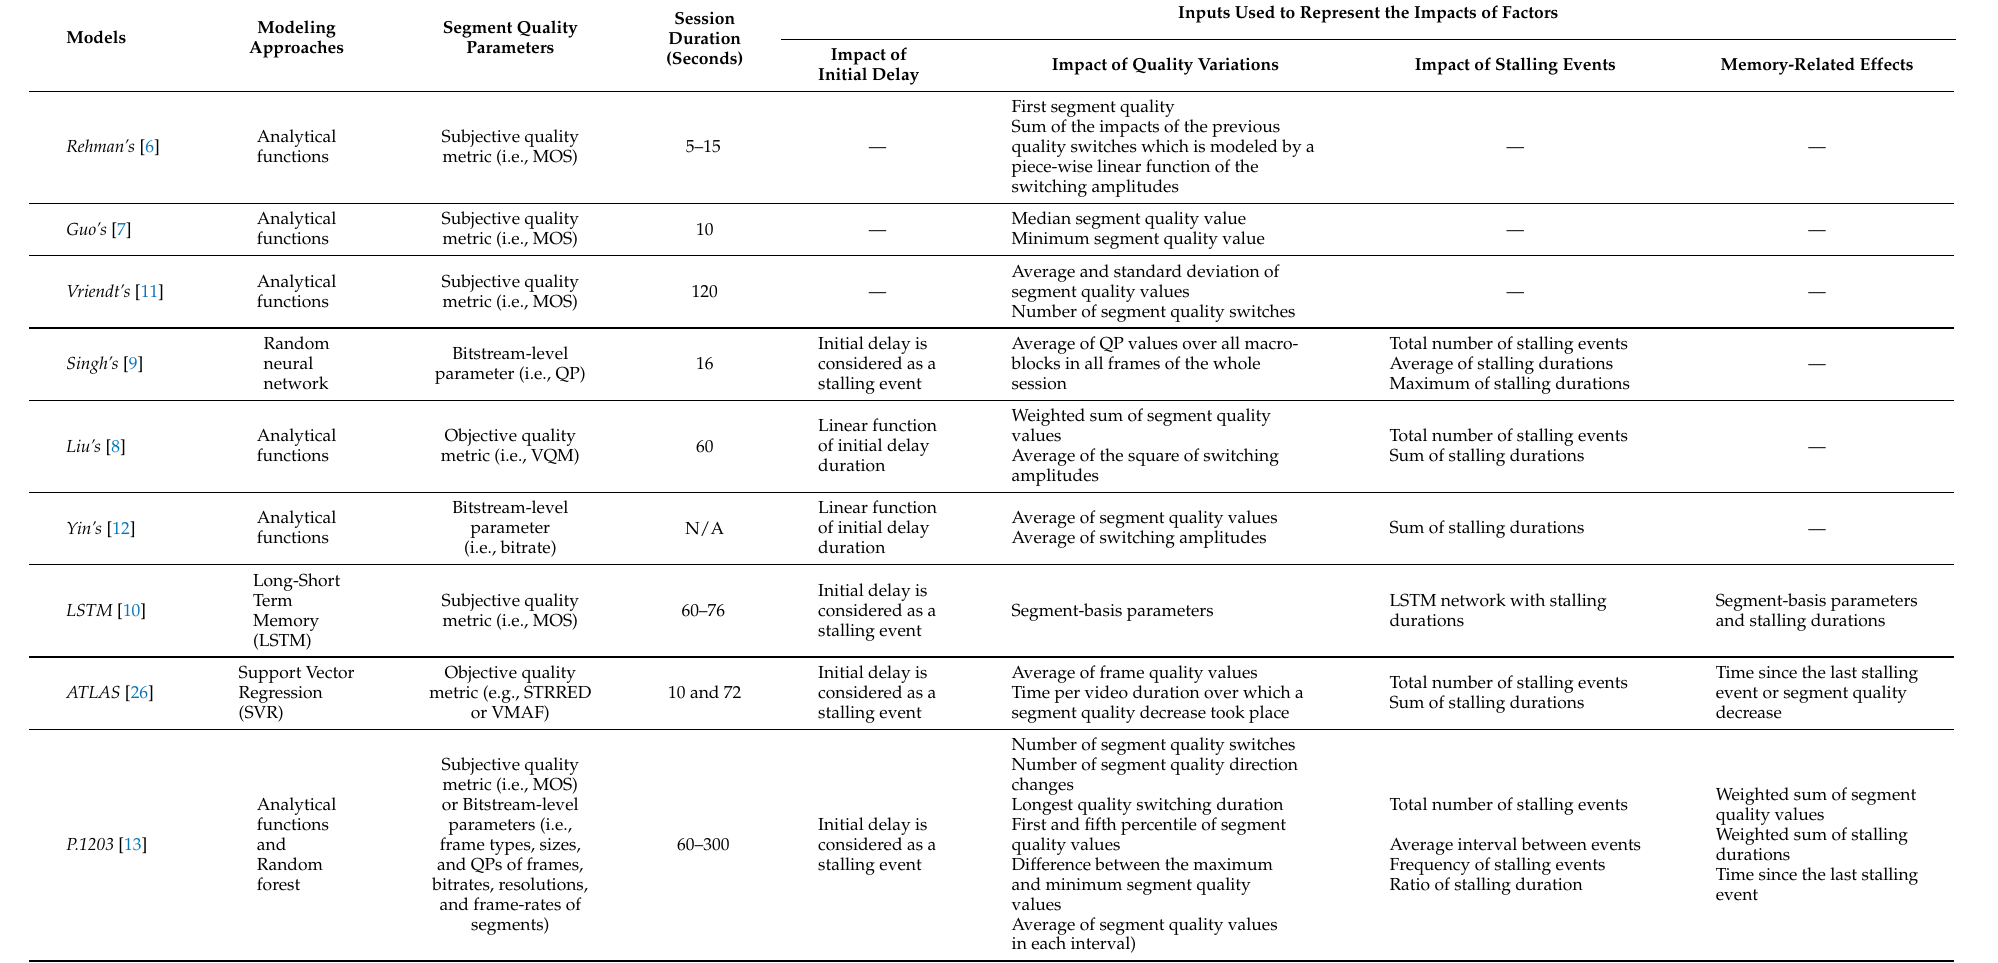
Table 1. Summary of existing